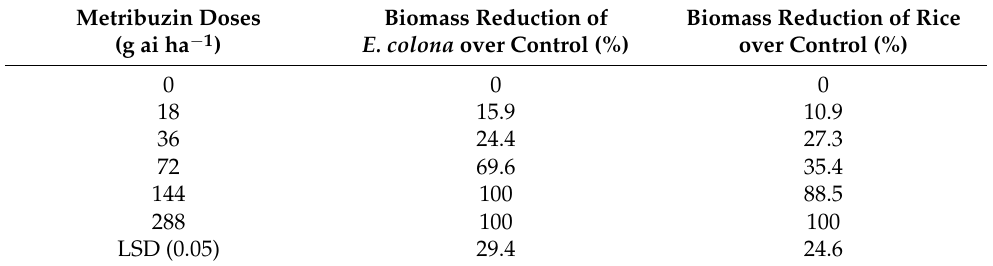
Table 4. Effect of metribuzin on percent biomass reduction of Echinochloa colona control and rice.